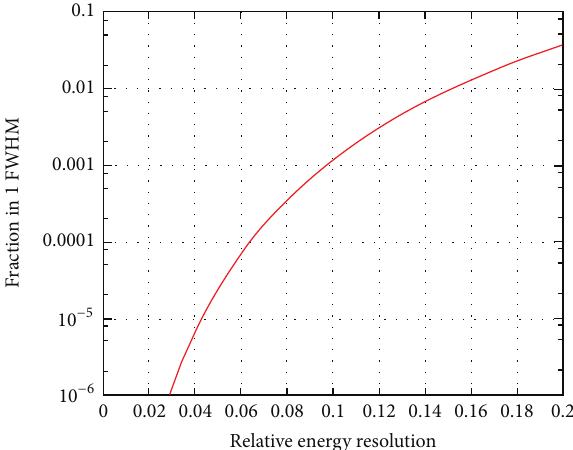
Figure 6: Fraction of the total 𝛽𝛽(2 ] ) counts expected in a window of total width equal to 1 FWHM as a function of the relative ( 𝜎/𝐸 ) energy